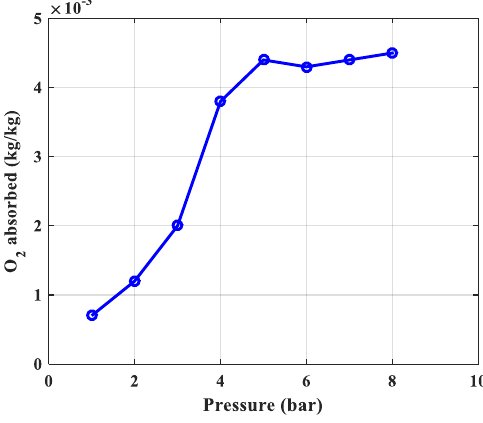
Figure 20. The amount of O2 gas absorbed depends on the pressure.